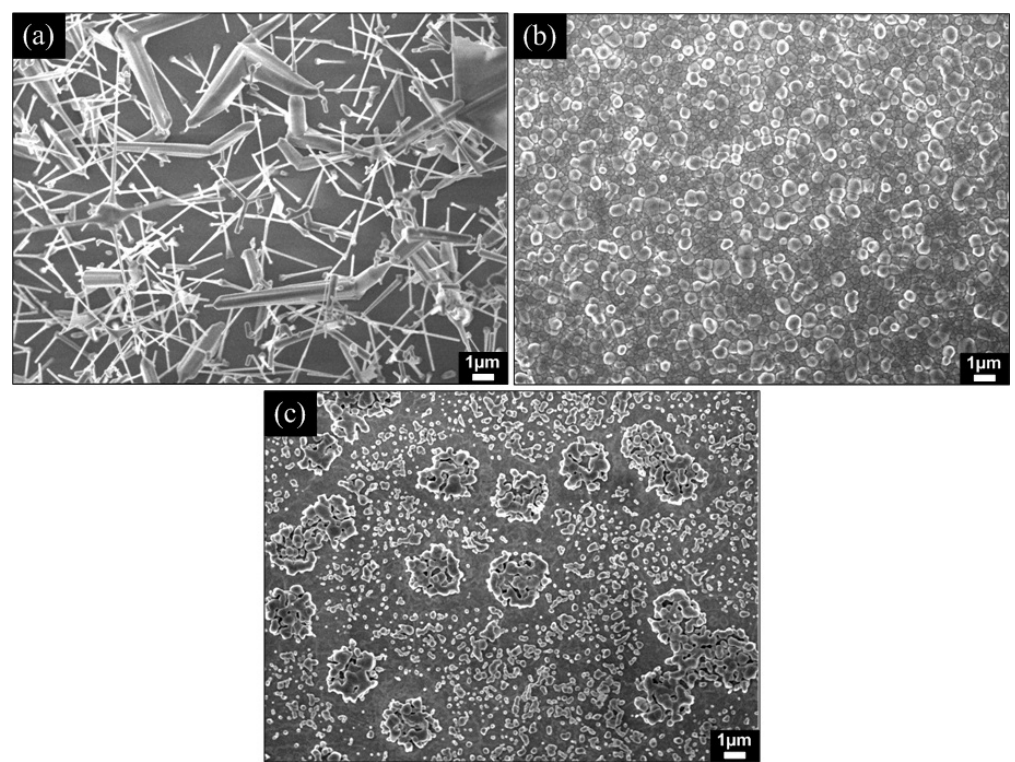
Figure 3. FESEM images of ZnO structures grown on Si(100) bulk substrates at different growth temperatures of ( a ) 600; ( b ) 800 and ( c ) 1000